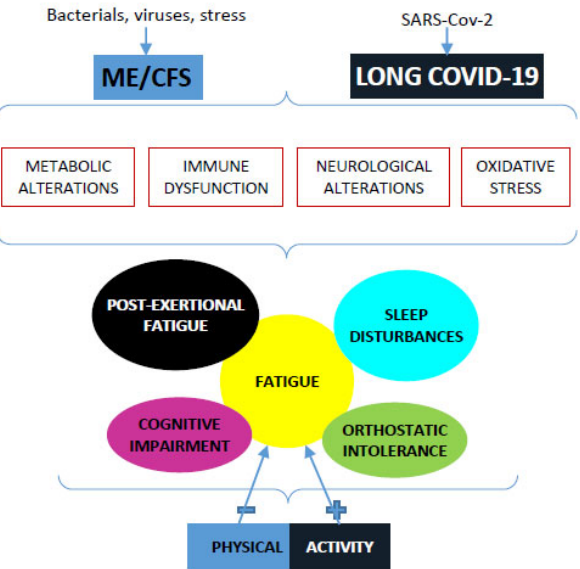
Figure 4. Similarities between ME/CFS and long COVID-19. Model depicting potential mechanisms involved in ME/CFS and long COVID-19. The combined effect of bacterial/virus insults and stress can trigger neurological, immune and metabolic dysfunction, and oxidative stress, which together could contribute to the symptomology observed in ME/CFS and long COVID-19 patients. Physical activity may be beneficial in the management of long COVID-19 but with more attention in ME/CFS